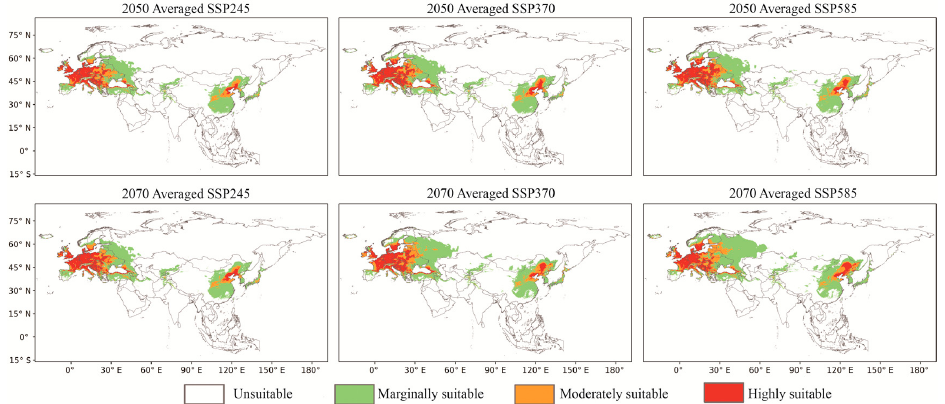
Figure 3. Averaged projected ranges of O. robiniae invasion for three climate change scenarios: SSP245, SSP370, and SSP585 for 2050 and 2070, SSPs = shared socio-economic pathways.